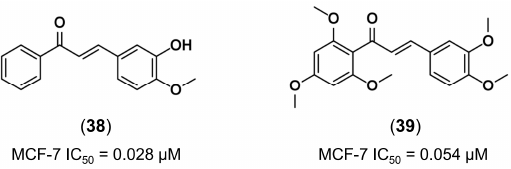
Figure 13. Chalcones with anticancer activity identified by integration of ligand-based pharmacophore screening and molecular docking studies [142].